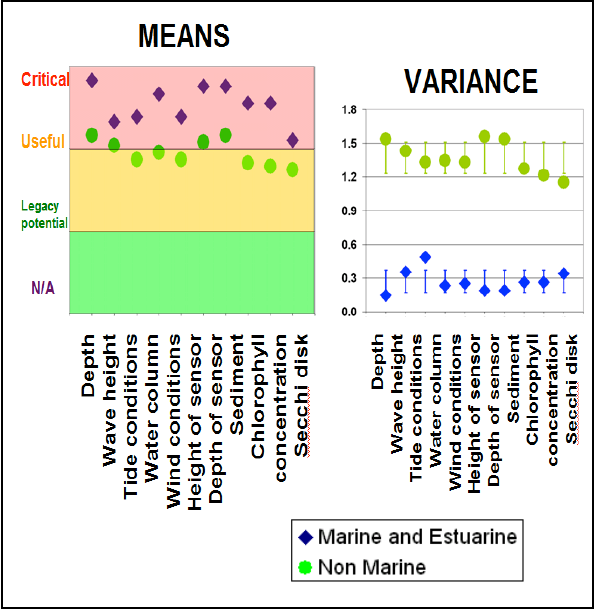
Figure 3.5 Group means and in ‘marine and